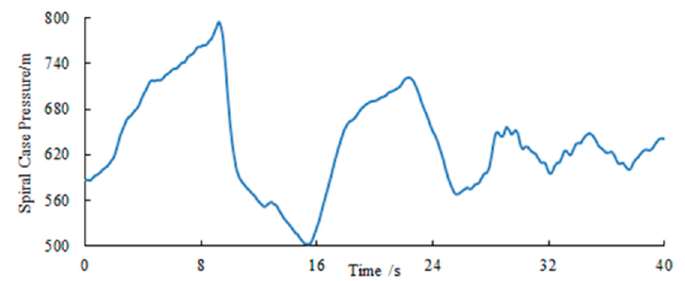
Figure 10. Pressure extreme process line of spiral case under simultaneous load rejection.